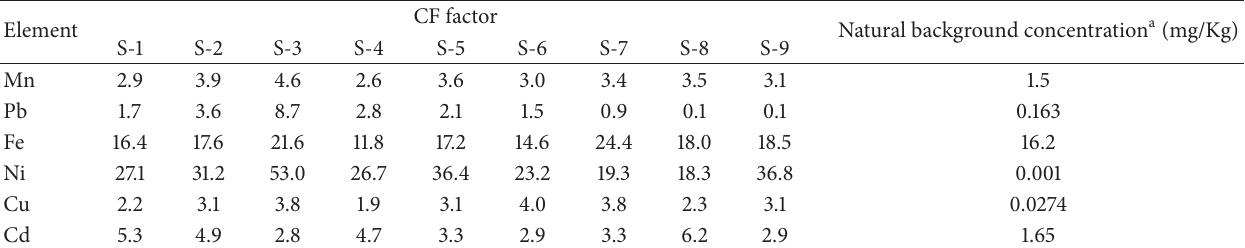
Table 3: Contamination factor (CF) calculation for minor elements in sediment